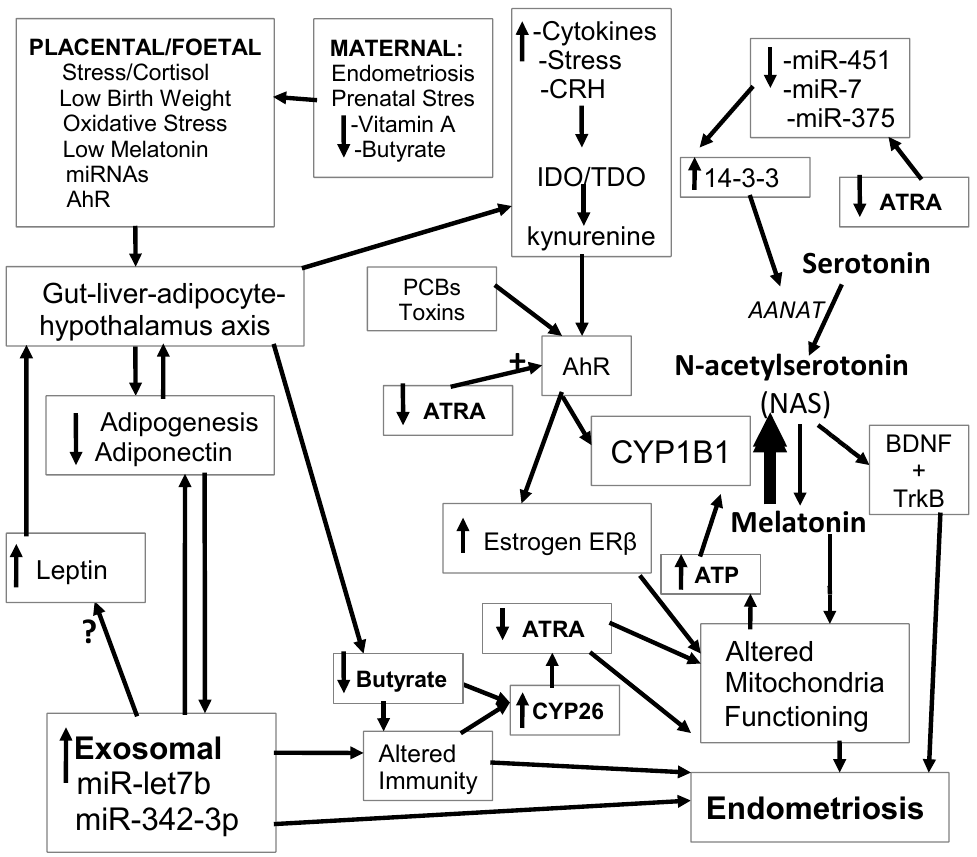
Figure 1: The melatonergic pathways integrate endometriosis